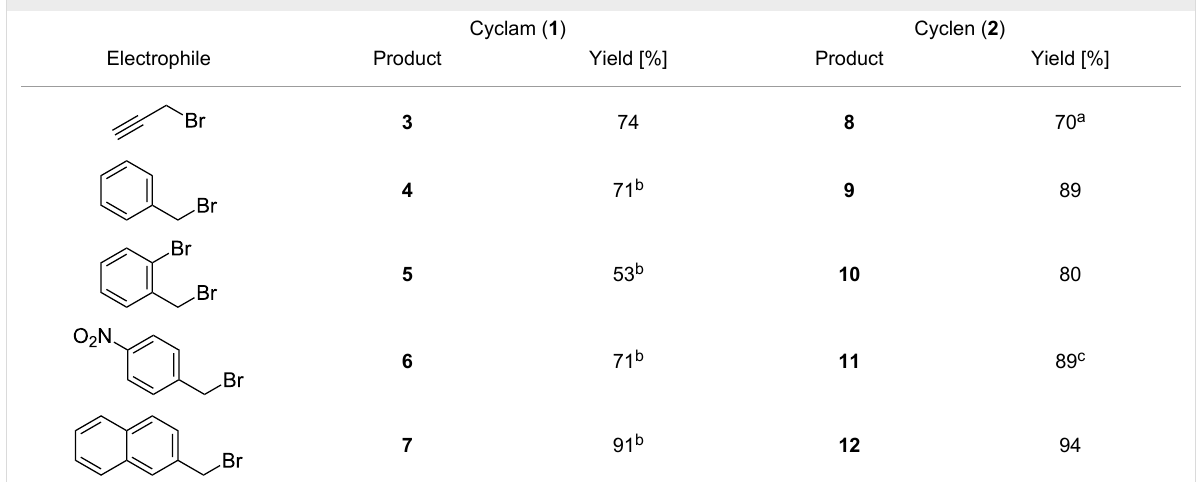
Table 1: Direct synthesis of N -tetraalkylated macrocycles 3 – 12 from cyclam ( 1 ) and cyclen ( 2